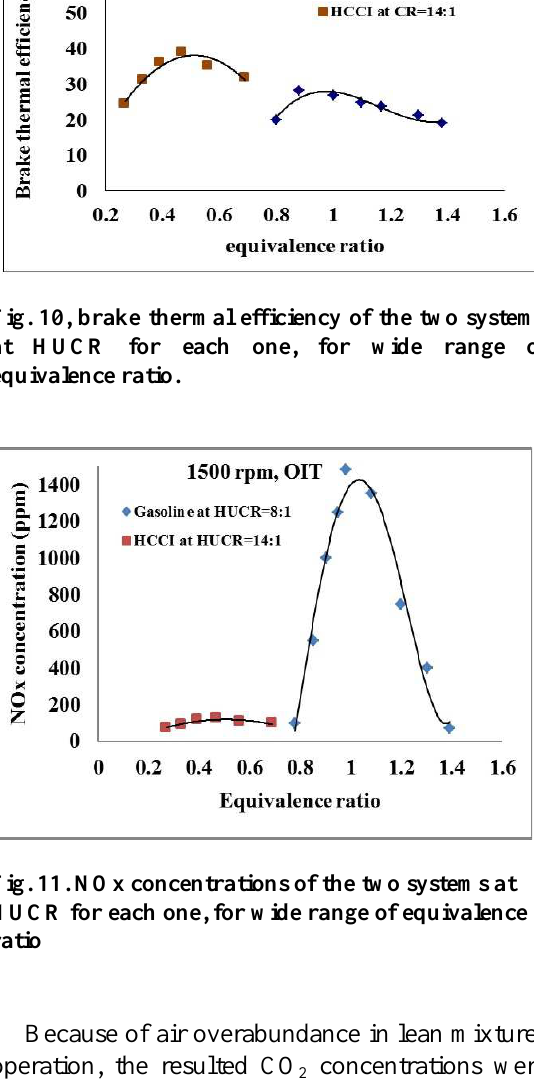
Fig. 9. Mechanical efficiency of the two systems at HUCR for each one, for wide range of equivalence ratios HCCI engine distinguished by near zero NOx concentrations, as Fig. 11 represents. The engine operation with lean equivalence ratio produced lower temperatures inside the combustion chamber. These temperatures are not enough for N and O to react effectively. 2 2